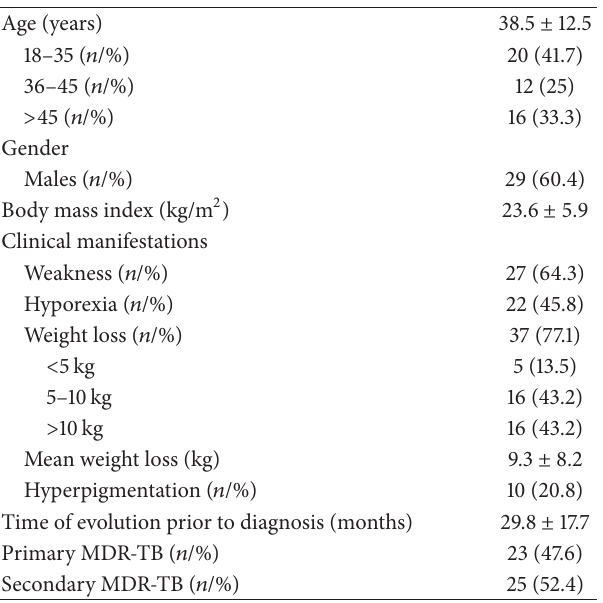
Table 1: Baseline characteristics of the studied population ( 𝑛 = 48